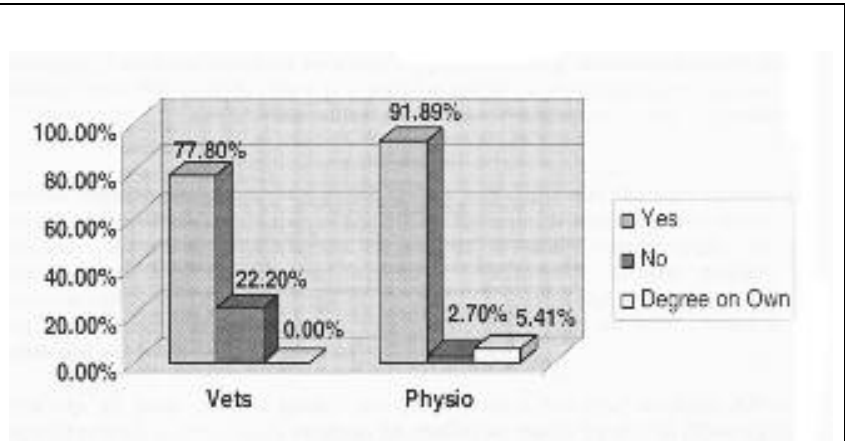
Figure 3: Comparison of veterinarians’ and physiotherapists’ views on post- graduate specialization in animal